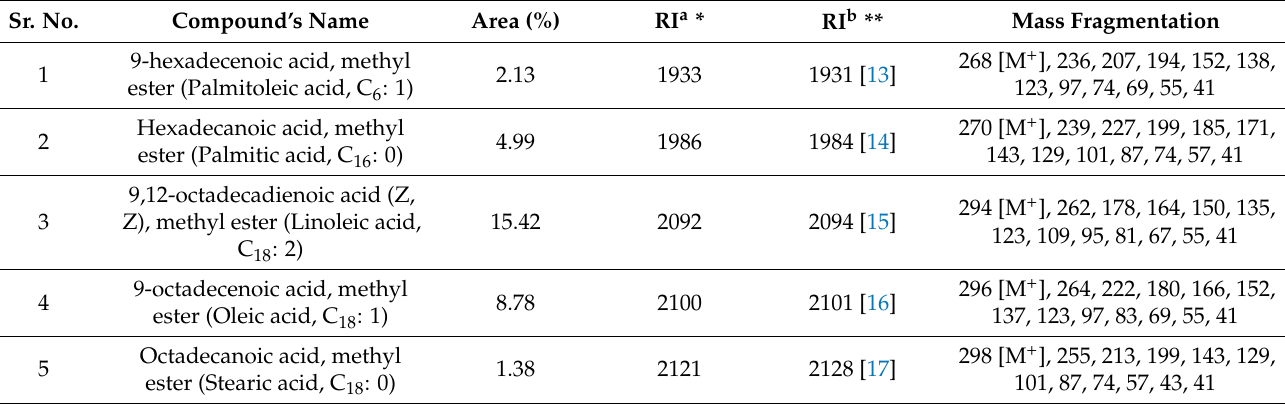
Table 1. Chemical composition of fatty acid methyl esters present in SO of Triadica sebifera . Sr.